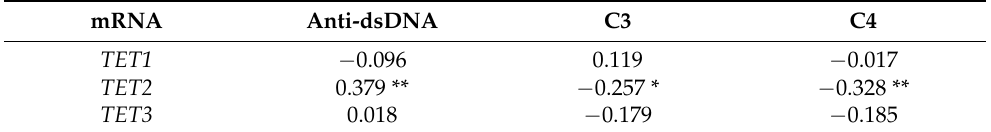
Table 4. Correlation (r) between TET mRNA and disease activity of systemic lupus erythematosus, defined by levels of anti-dsDNA, C3, and C4.